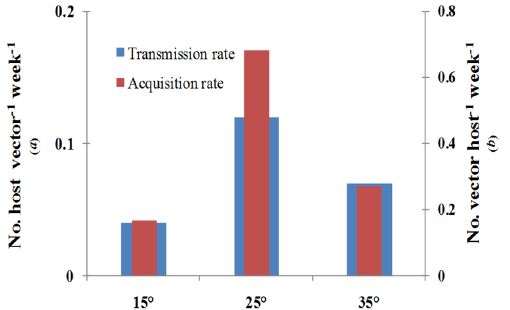
Figure 1. Transmission parameter estimates at 15 °C, 25 °C and 35 °C on susceptible chili cultivar (cvHPH- 1041) under semi-controlled conditions (eight plants grown in insect-proof cage; ten viruliferous whiteflies released through suction device; 7 days after release flies were killed spraying Confidor (@ 1 ml/L), blue bar = transmission rate ( a) and red bar = acquisition rate ( b ); a and b estimated fitting the equation dS/dt = – aVS and dV/dt = b XI = b(1 − V)I